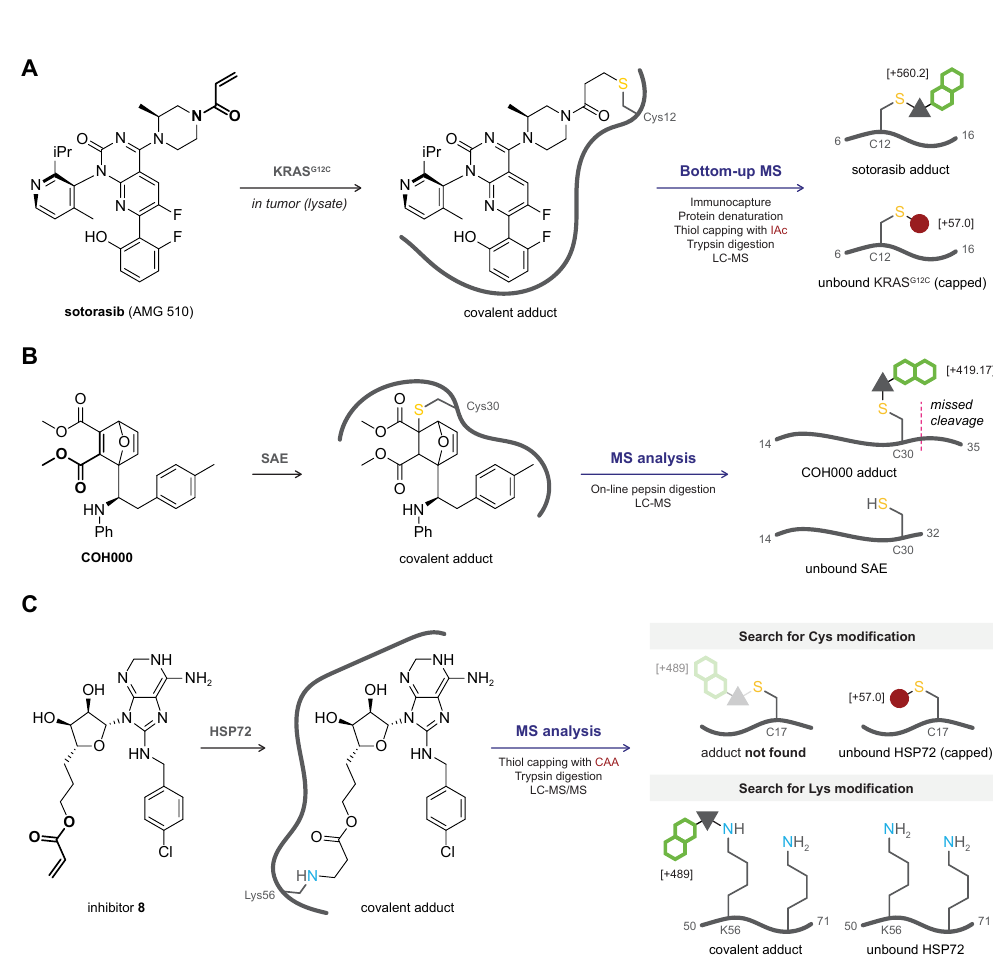
Figure 4. Bottom-up MS analysis of covalent protein–drug adducts. ( A ) Detection of covalent adduct formation for clinically approved covalent inhibitor sotorasib (AMG 510) with KRAS G12C isolated from lysates originating from (in vitro or in vivo) treated tumor cells [18,99]. ( B ) Identification of covalent adduct formation between recombinant SUMO E1 (SAE) and covalent inhibitor COH000 [70] reveals unexpected modification of allosteric Cys30 rather than catalytic Cys173. Covalent modification of Cys30 interferes with pepsin-mediated digestion, generating longer adduct peptides than in the untreated control (missed cleavage). ( C ) Bottom-up MS analysis of recombinant HSP72 incubated with covalent acrylamide ligand 8 revealed covalent modification of Lys56 rather than catalytic Cys17 [71]. Data analysis focused on lysine modification resulted in detection of the simple adduct of L50–K71